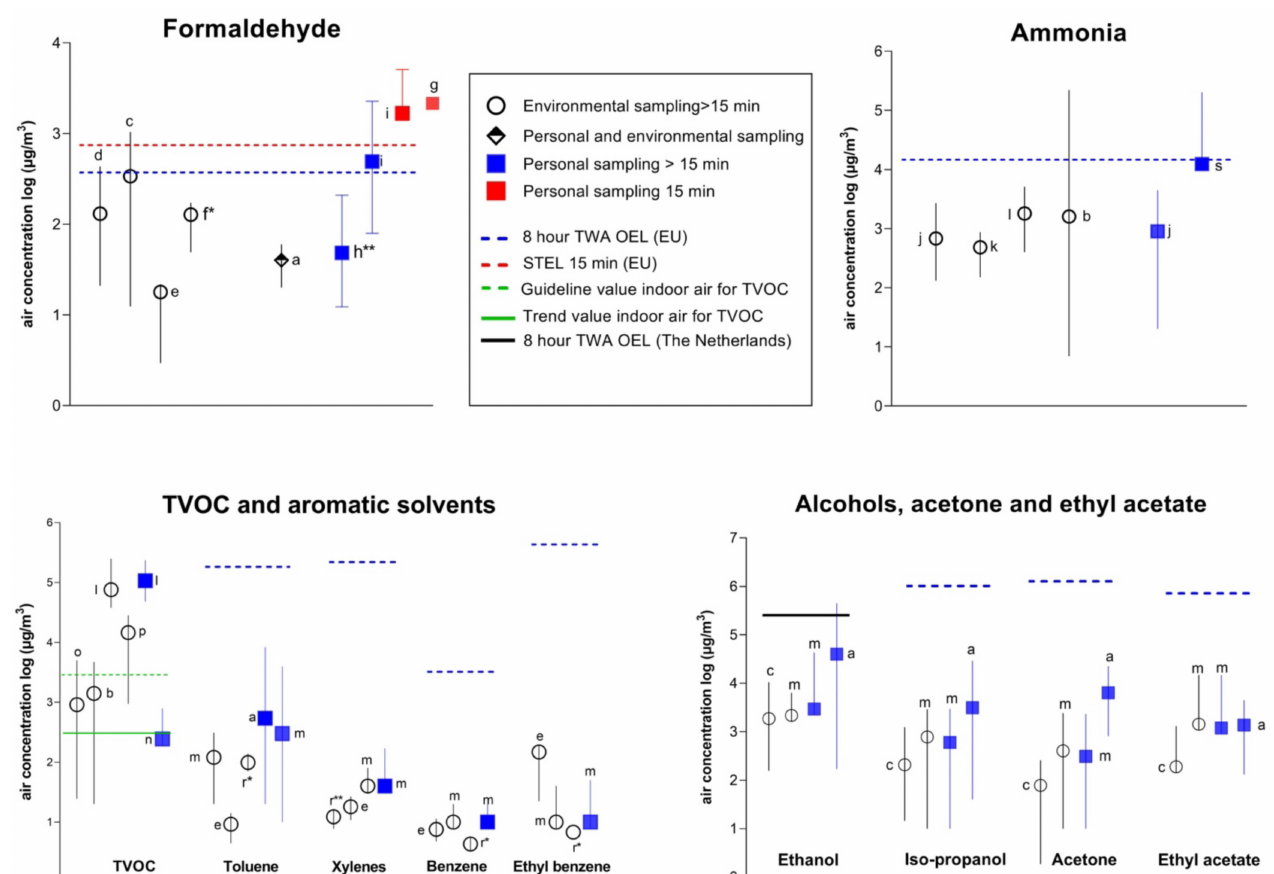
Figure 2. Air concentrations of formaldehyde, ammonia, TVOC, aromatic and aliphatic solvents obtained from personal and environmental samples. The letters by the symbols refer to reference numbers as follows: a [5]; b [6]; c [30]; d [31]; e [32]; f [33]; g [34]; h [35]; I [36]; j [37]; s [38]; k [39]; l [40]; m [41]; n [42]; o [43]; p [44]; r [45]. Data are presented as mean and ranges unless indicated otherwise. * Median and range. ** Mean of medians and range. OEL: occupational exposure